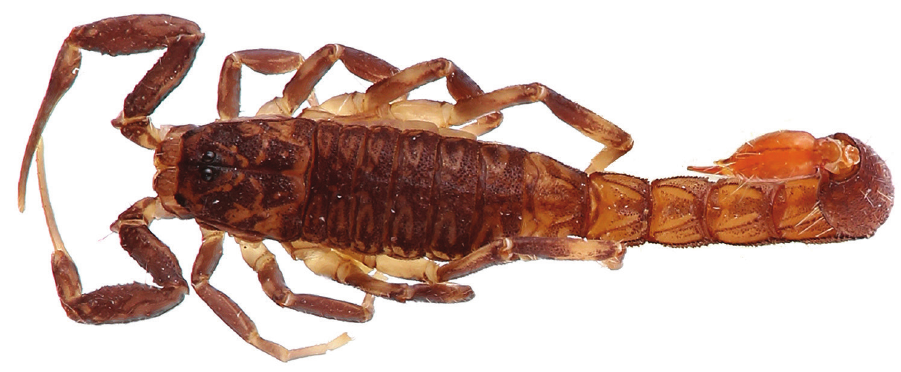
Figure 6. Ananteris polleti , male holotype from Mitaraka (photo MNHN / E.-A. Leguin; 2016 Elsevier Masson